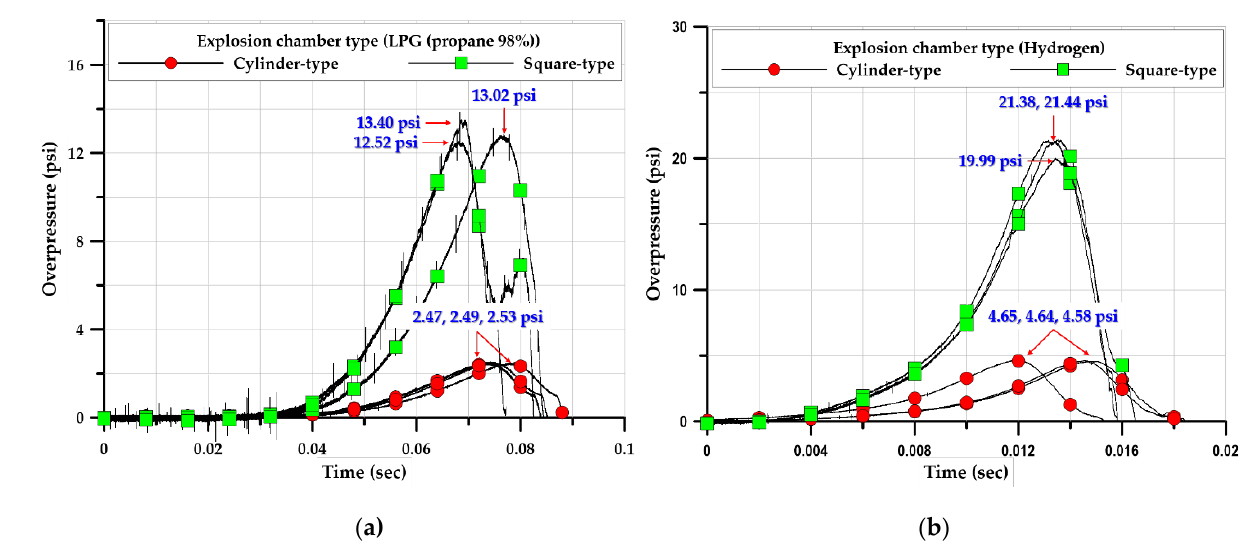
Figure 23. Comparison of explosion overpressure for explosion chamber geometry; ( a ) LPG (propane 98%), ( b ) Hydrogen.